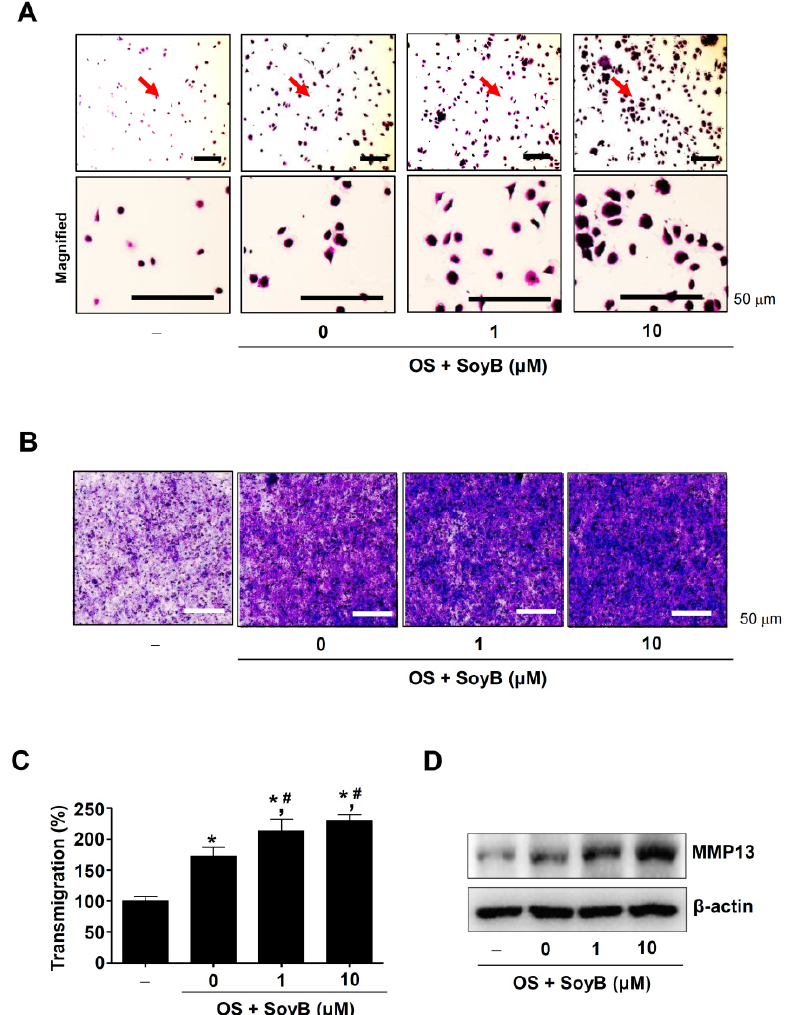
Figure 5. Osteogenic effects of SoyB on cell adhesion and transmigration. ( A ) SoyB-treated cells were seeded onto Matrigel-coated plates, fixed, and stained for 120 min. Cell adhesion was visu- alized under a light microscope. Magnified regions are indicated by red arrows. Scale bar: 50 μ m. ( B , C ) Transmigration of SoyB-treated cells was observed using a light microscope ( B ), and the numeric values (%) are shown as a bar graph. Scale bar: 50 μ m. ( D ) MMP-13 levels were assessed using Western blot analysis. *, p < 0.05 was considered statistically significant when compared to the control. #, p < 0.05 was considered statistically significant when compared to OS.